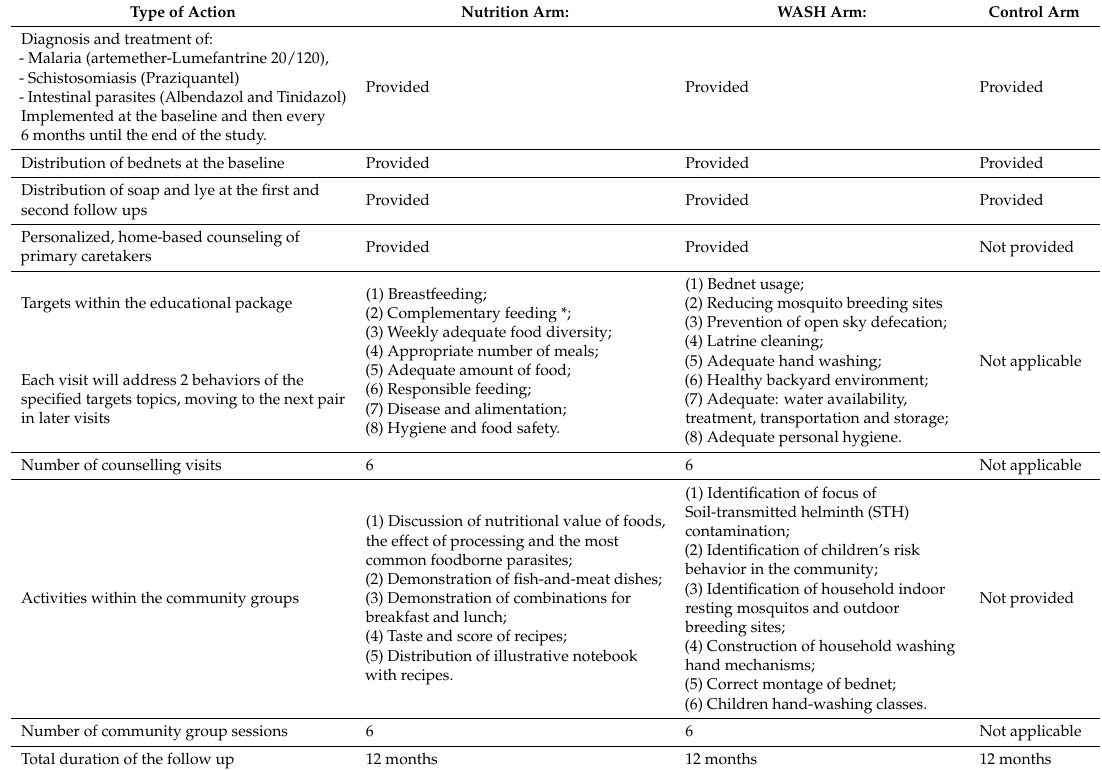
Table 1. Summary of the treatment given in each